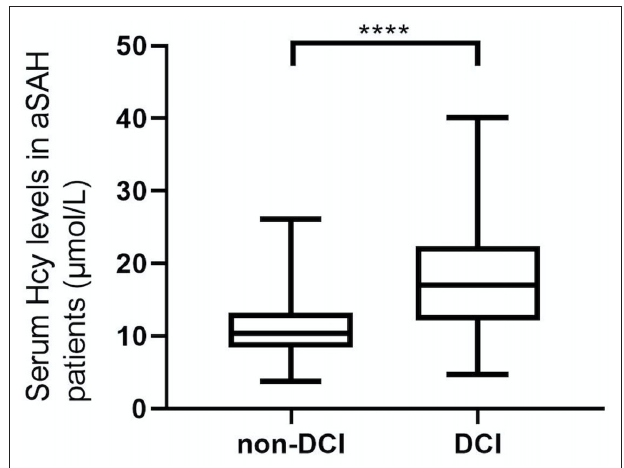
FIGURE 2 | Difference in serum homocysteine (Hcy) levels between patients with DCI and patients without DCI. Patients with DCI had significantly higher serum Hcy levels than those without ( P < 0.001). ***Statistical significance P < 0.001.